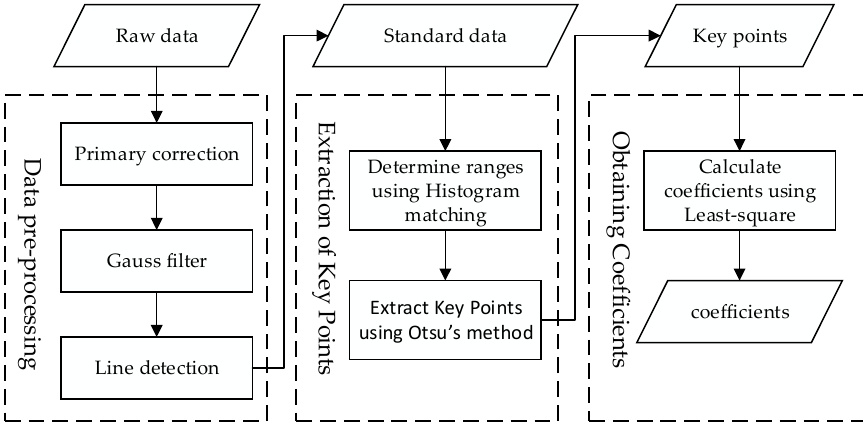
Figure 3. The relative radiometric calibration method based on side-slither data.